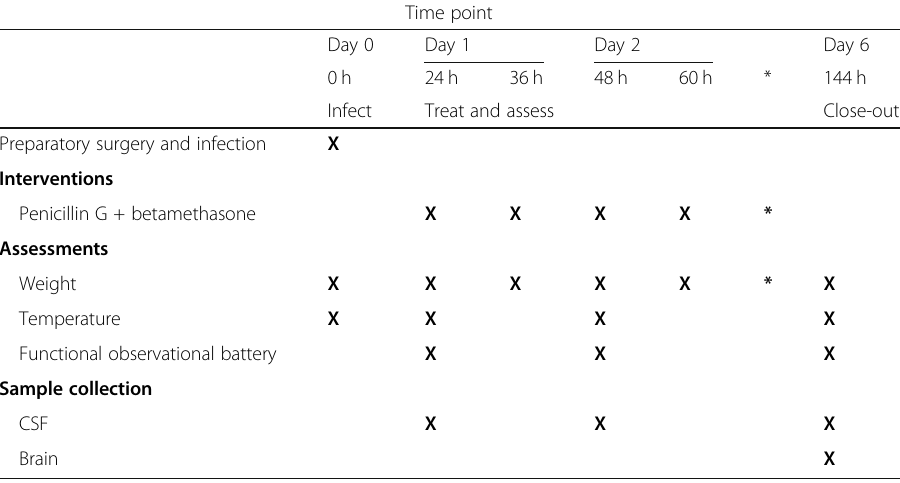
Table 1 Schedule of interventions and